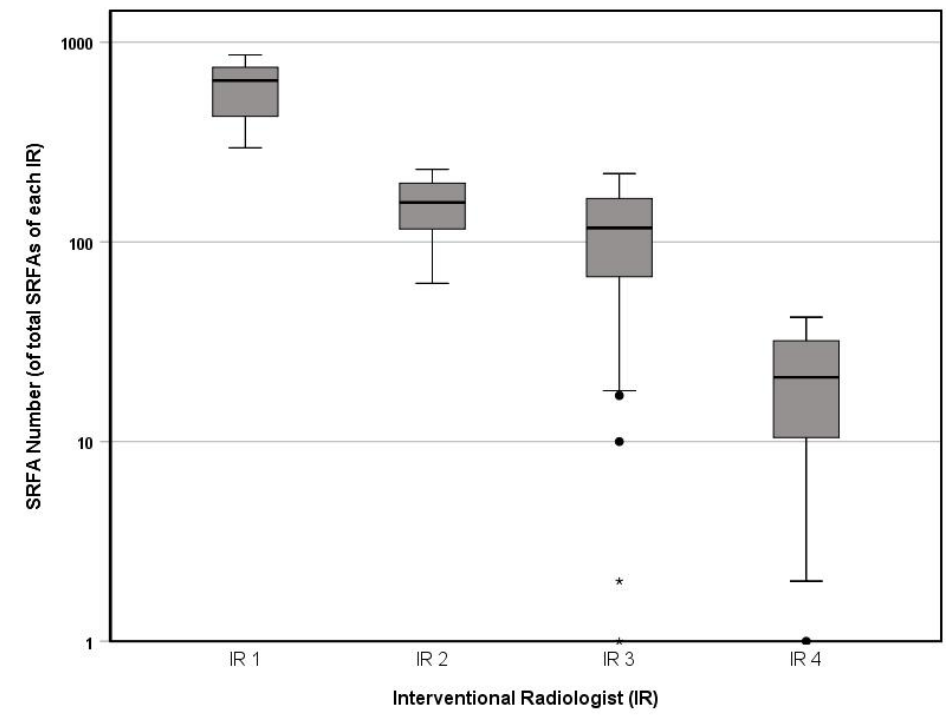
Figure 3. Boxplot comparison of continuous SRFA numbers based on the total executed SRFAs by each IR (logarithmic scale).